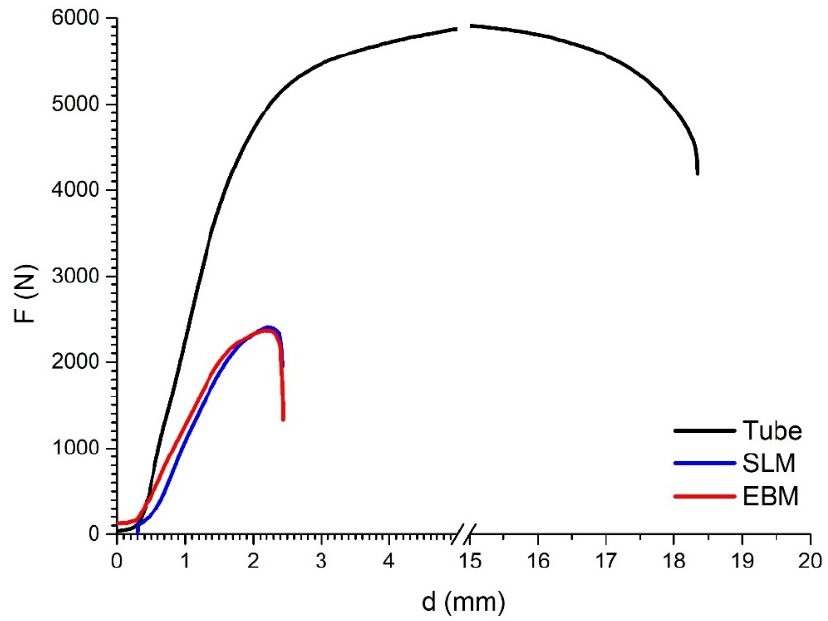
Figure 7. Tensile force (F) versus displacement (d) for two representative cases of SLM and EBM and for the unwelded base Ti tube.